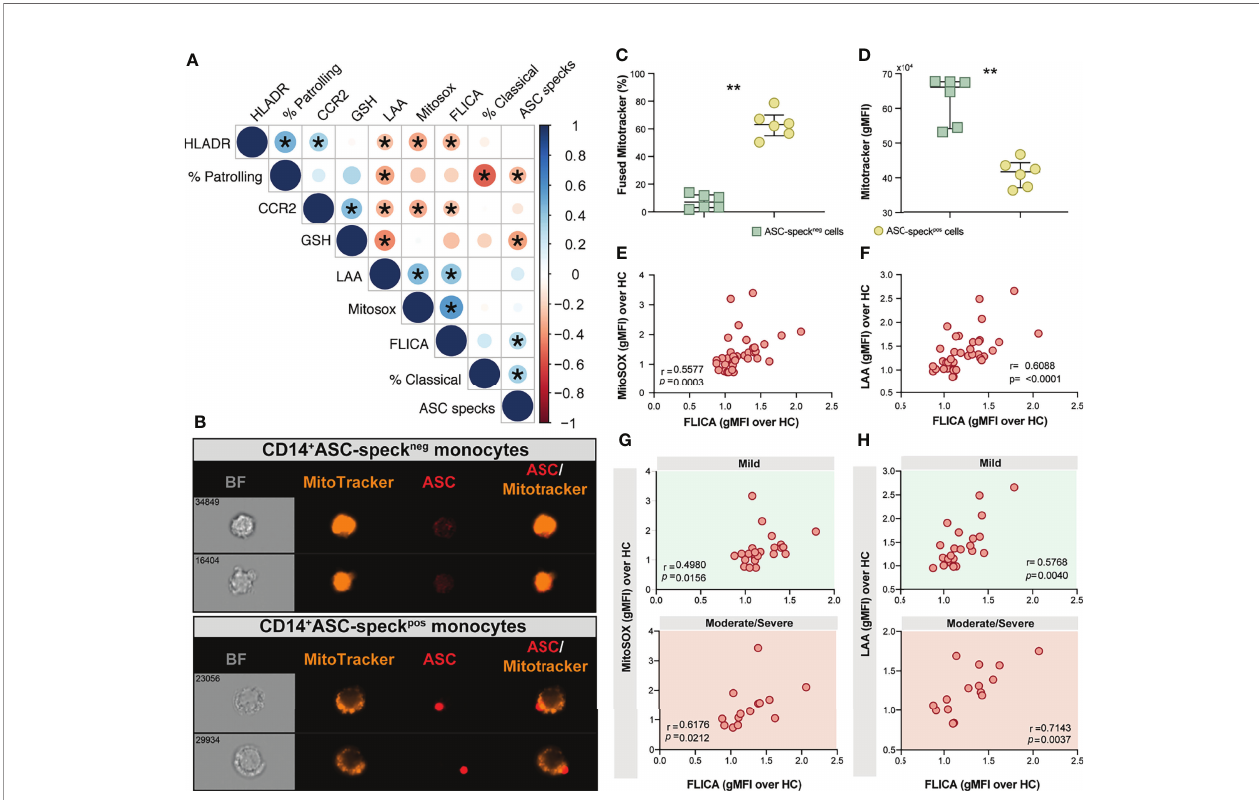
FIGURE 5 | Oxidative stress and in fl ammasome responses are associated in COVID-19 patients. (A) Multi-parameter Spearman ’ s correlation analysis of PBMC samples from healthy control (HC) and COVID-19 patients (*P < 0.05 or less). (B) PBMCs from COVID-19 patients (n = 6) were incubated with Mitotracker Red, stained for intracellular ASC and acquired by means of Imaging fl ow cytometry. Representative images showing respectively: BF (bright fi eld), Mitotracker Red, ASC and a composite image of both Mitotracker Red and ASC markers merged, were selected from a CD14 + ASC-speck neg gate (top panel) and a CD14 + ASC-speck pos gate (bottom panel). (C) The percentage of monocytes showing the diffuse pattern for Mitotracker Red shown in (B) (top panel) versus the aggregated staining pro fi le as shown in B (bottom panel) was determined after application of Major Axis Intensity_M04_Ch4 × Mean Pixel_M04_Ch4 features inside both CD14 + ASC-speck neg and CD14 + ASC-speck pos gates using IDEAS software. (D) Loss of mitochondrial membrane potential ( DY m) was determined by the change of Mitotracker Red gMFI staining on CD14 + ASC-speck neg and CD14 + ASC-speck pos subsets. Data are presented as median values and interquartile ranges and were analyzed using the Mann – Whitney test (**P < 0.01). (E, F) Spearman correlations between FLICA and MitoSOX (E) or FLICA and LAA (F) levels whithin CD14 high CD16 − monocytes from COVID-19 patients. (G, H) Spearman correlations between FLICA and MitoSOX (G) or FLICA and LAA levels (H) on CD14 high CD16 − monocytes obtained from COVID-19 patients grouped based on their disease severity in patients experiencing mild symptoms (top panel, green) or moderate to severe cases of COVID-19 (bottom panel, red). Each dot represents a correspondent value from each patient. ns , not signi fi